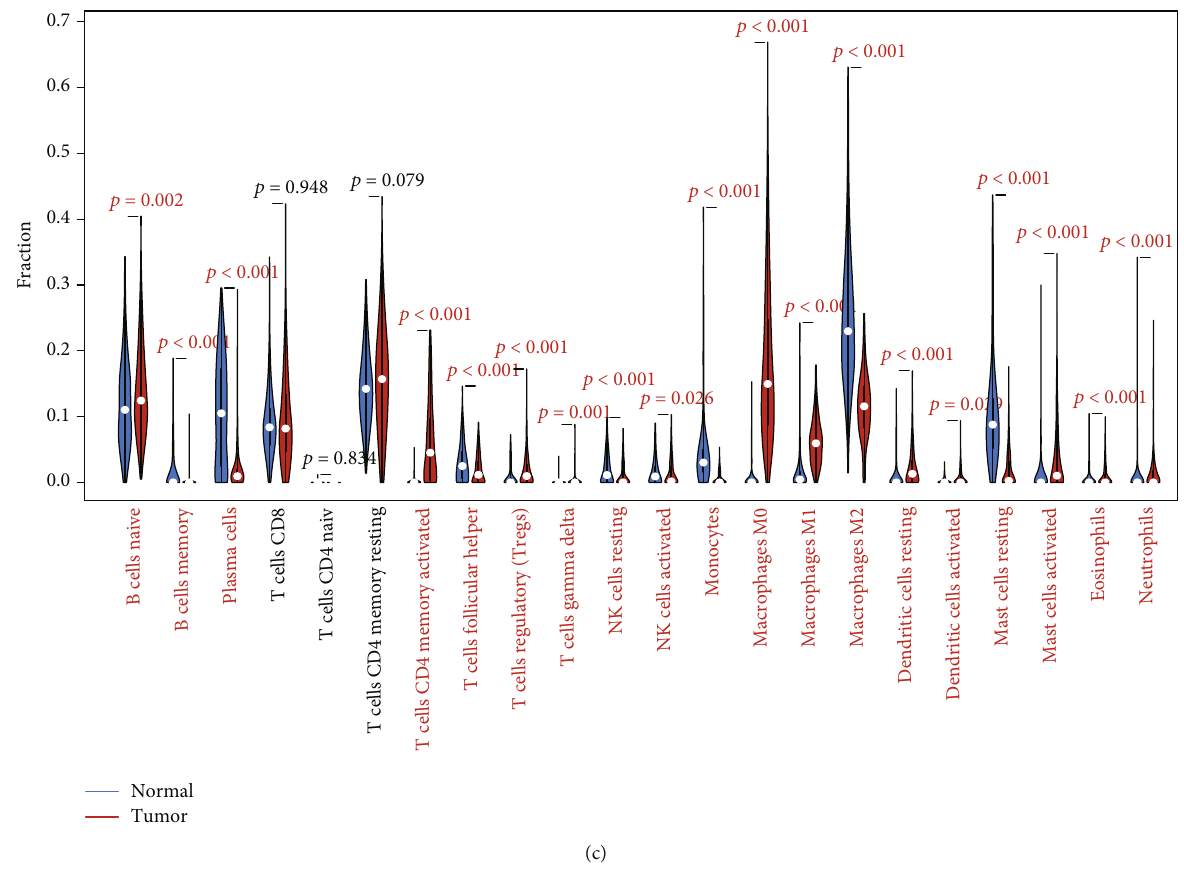
Figure 5: The distribution of 22 di ff erent types of TII cell in 514 CRC samples via CIBERSORT are shown by bar plots (a, b), and the distributional di ff erence of the TII cells between the normal and tumor samples is illustrated in